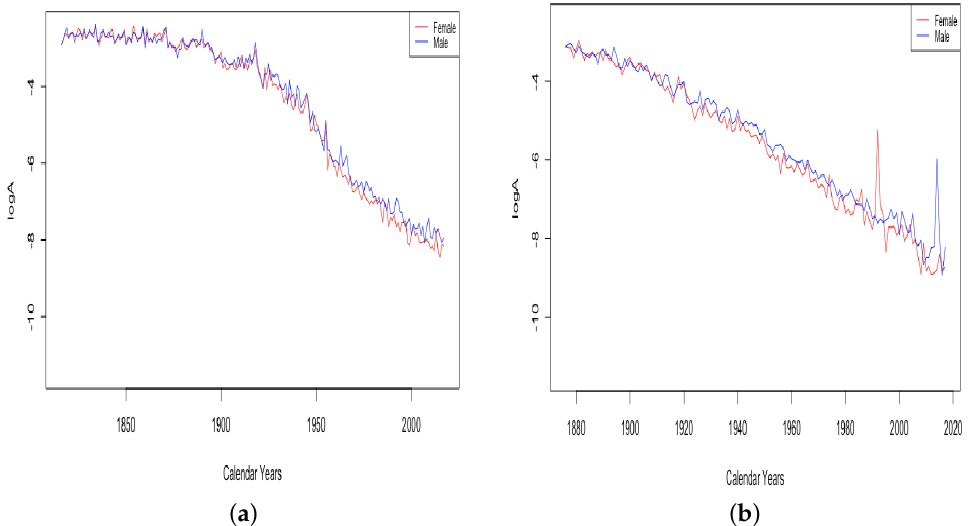
Figure 4. ( a ) The log of infant mortality A in France, male vs. female. ( b ) The log of infant mortality A in Switzerland, male vs.